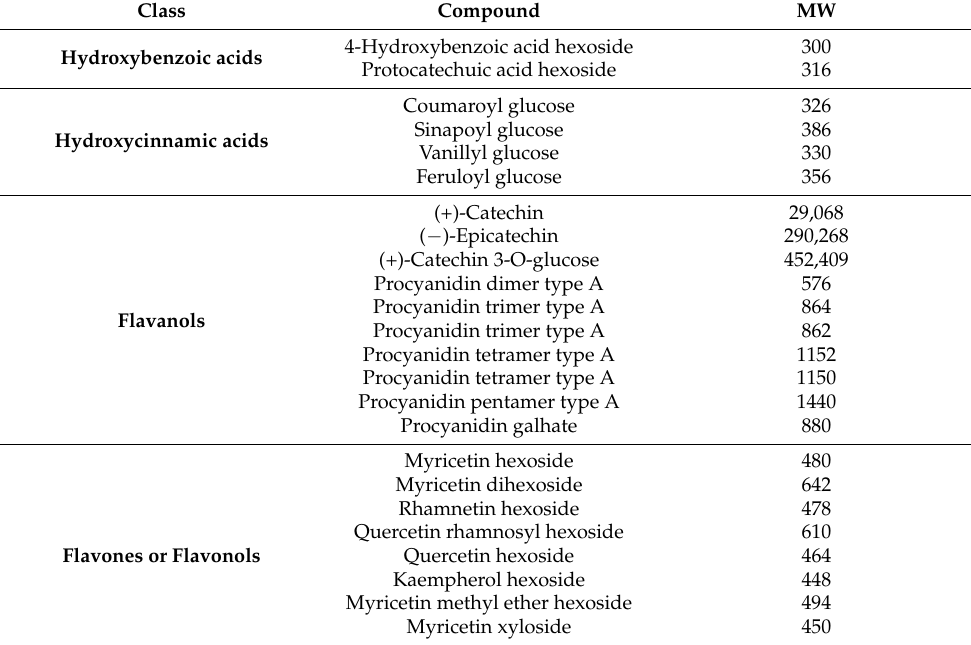
Table 1. Phenolic compounds tentatively identified in ECAL by mass